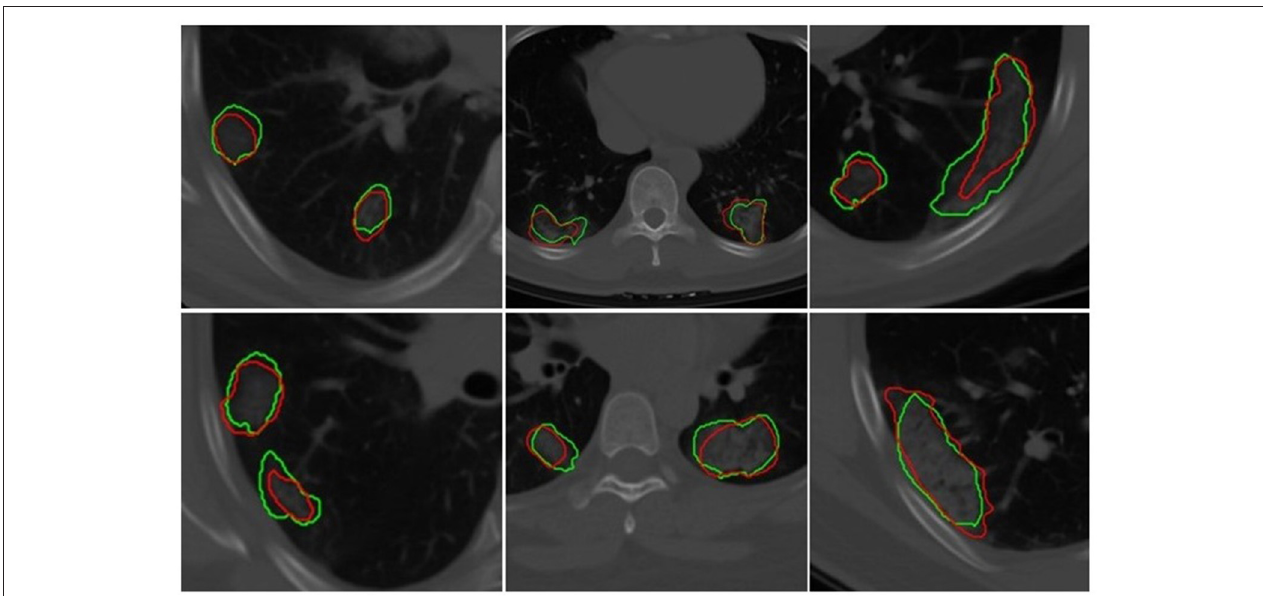
FIGURE 3 | Segmentation results of a 2D U-Net in segmenting ground-glass opacities and COVID consolidation regions. Green contours represent ground-truth delineations of the ground-glass opacities (GGOs) and consolidations, and their corresponding network segmentation contours are represented in red. The 2D U-Net network was trained on the subset of the training set.